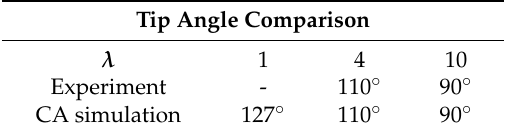
Table 2. Comparison of calculated tip angles with Fujiwara’s experiment results.